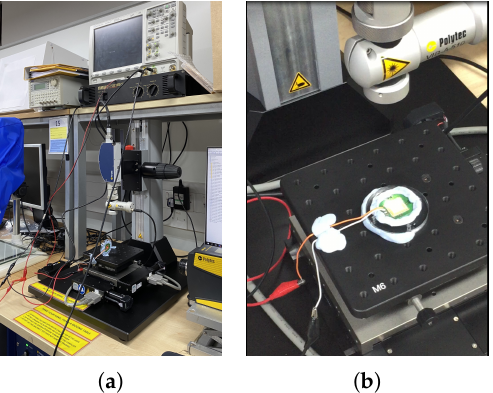
Figure 17. ( a ) Overview and ( b ) moving table with device under test of the vibration measurement